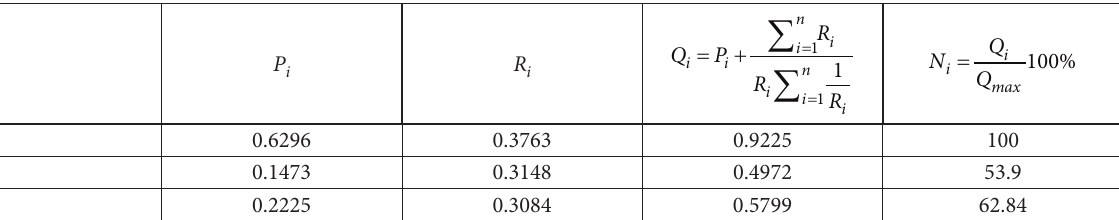
Table 9. Risk allocation for uncertain tariff reviews risk